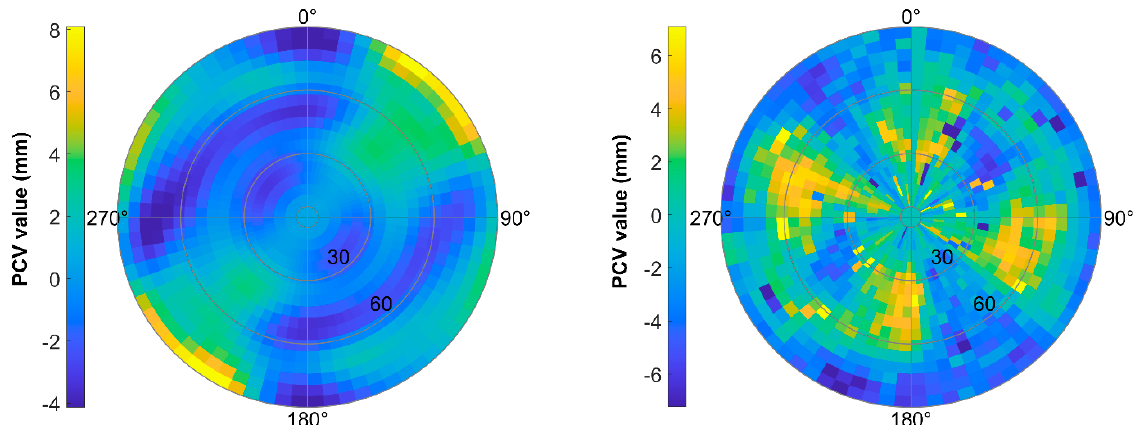
Figure 6. PCV patterns with 5° resolution for the CubeSat antenna (Lemur 3.1.0) from the antenna calibration ( left ) and the inflight observations using the residual approach ( right ). The inner circles are marked with the elevation angles, and the azimuth values are tagged on the outer circle. The azimuth 0° coincides with the positive x-axis of the CubeSats’ body frame (approximately the positive velocity direction) in the zero-quaternion case.